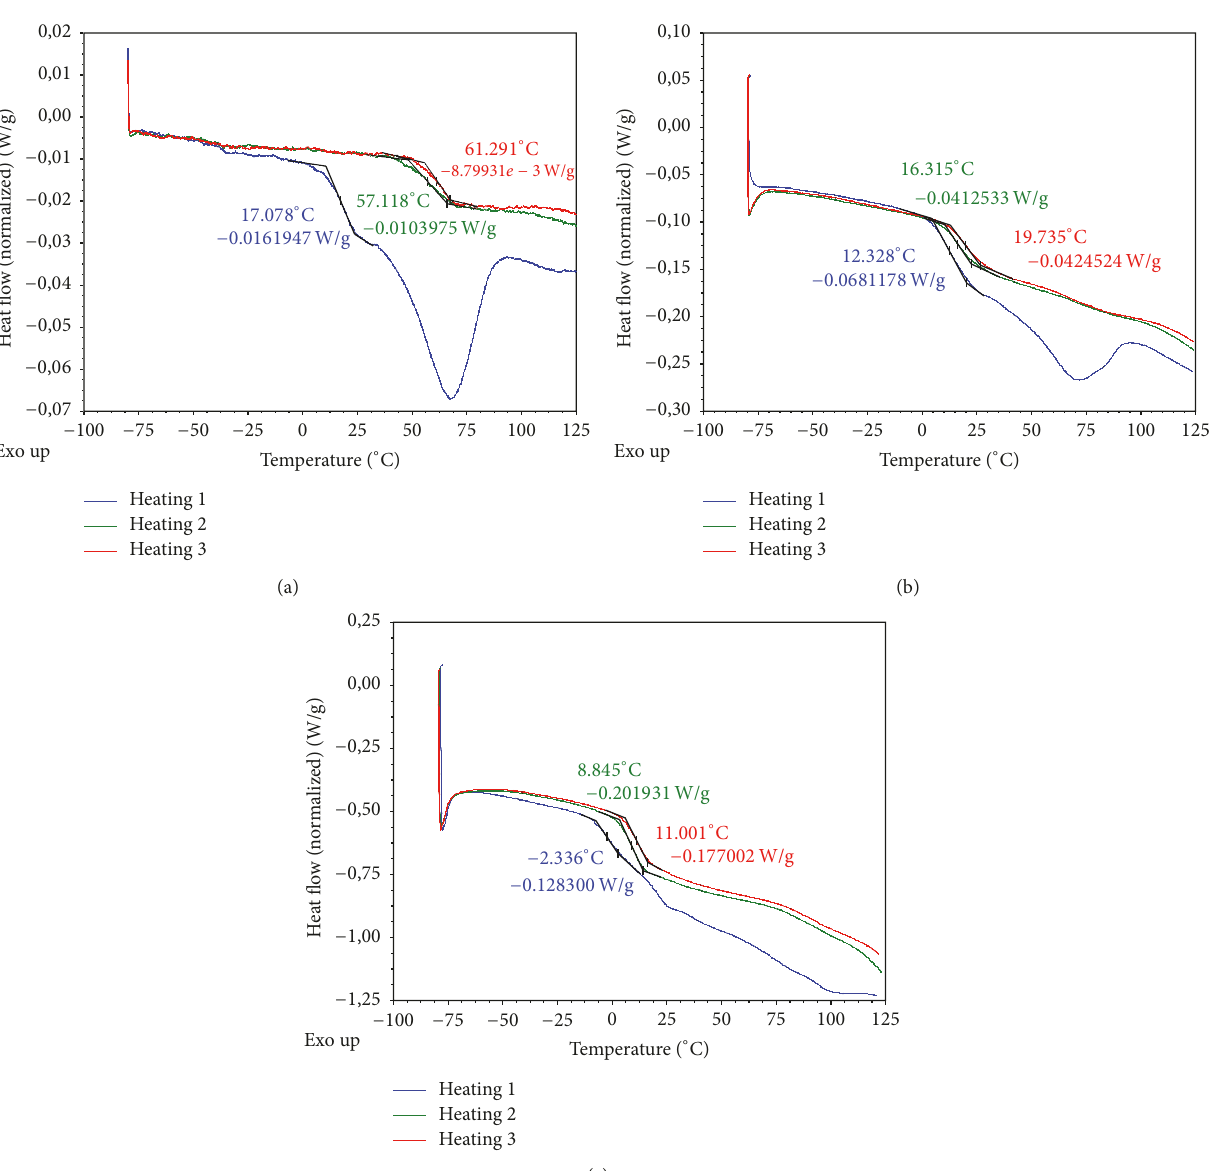
Table 3: Percentages of weight loss and weight accumulated obtained from the TGA curves of OsLu and Vivinal GOS. Range of temperature ( ∘ C) Weight loss (%) Weight accumulated (%) OsLu